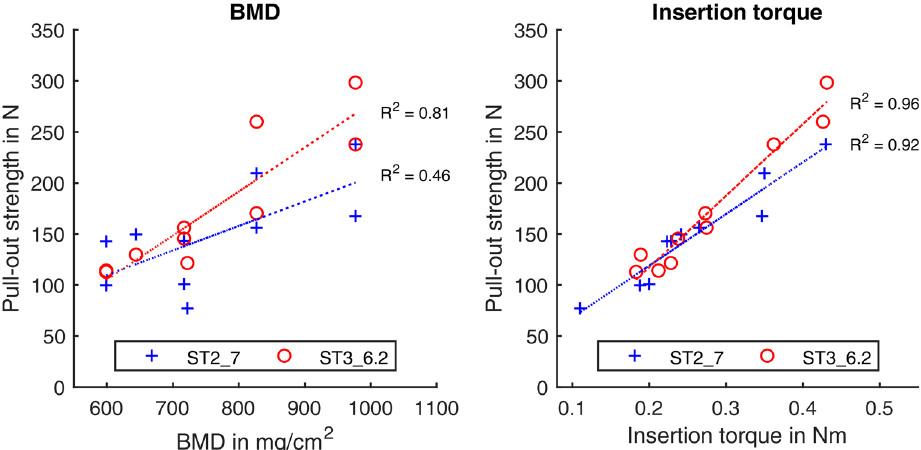
Figure 8. Representation of the pull-out strengths from vertebral bodies of body donors as a function of the bone mineral density BMD (left) and the insertion torque (right), with differentiation of the screws ST2_7 and ST3_6.2